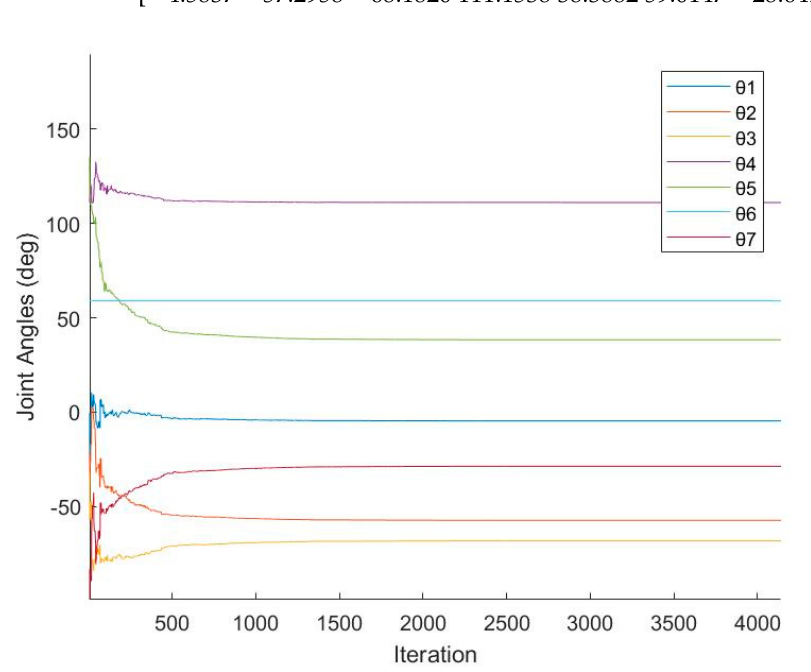
Figure 6. Baxter’s left-arm in joint con fi gurations of runs 1, 2 and 3 (in left to right order).